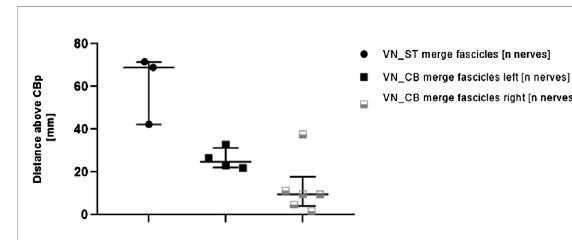
FIGURE 6 Comparisons of distances measured for the fi rst fascicle exchangeabovethecardiacbranchingpointbetween1)VNandST (left column, VN_ST) and 2) VN and CB (middle and right column, VN_CB merge fascicles left/right). Each point or square represents one nerve. The distances between the corresponding fascicle merging positions and the cardiac branching points were measured in the µCT stacks. Since more fascicle-merging events were counted for the VN_CB, they were also compared between the left and the right side. Data are represented as median and interquartilerange.CBp,cardiacbranchingpoint;VN,vagusnerve; ST, sympathetic